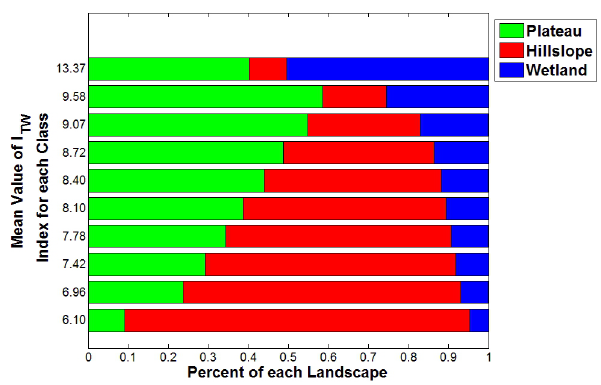
Fig. 12. The analysis for 10 classes of the topographical wetness index ( I TW ) and landscape component of each